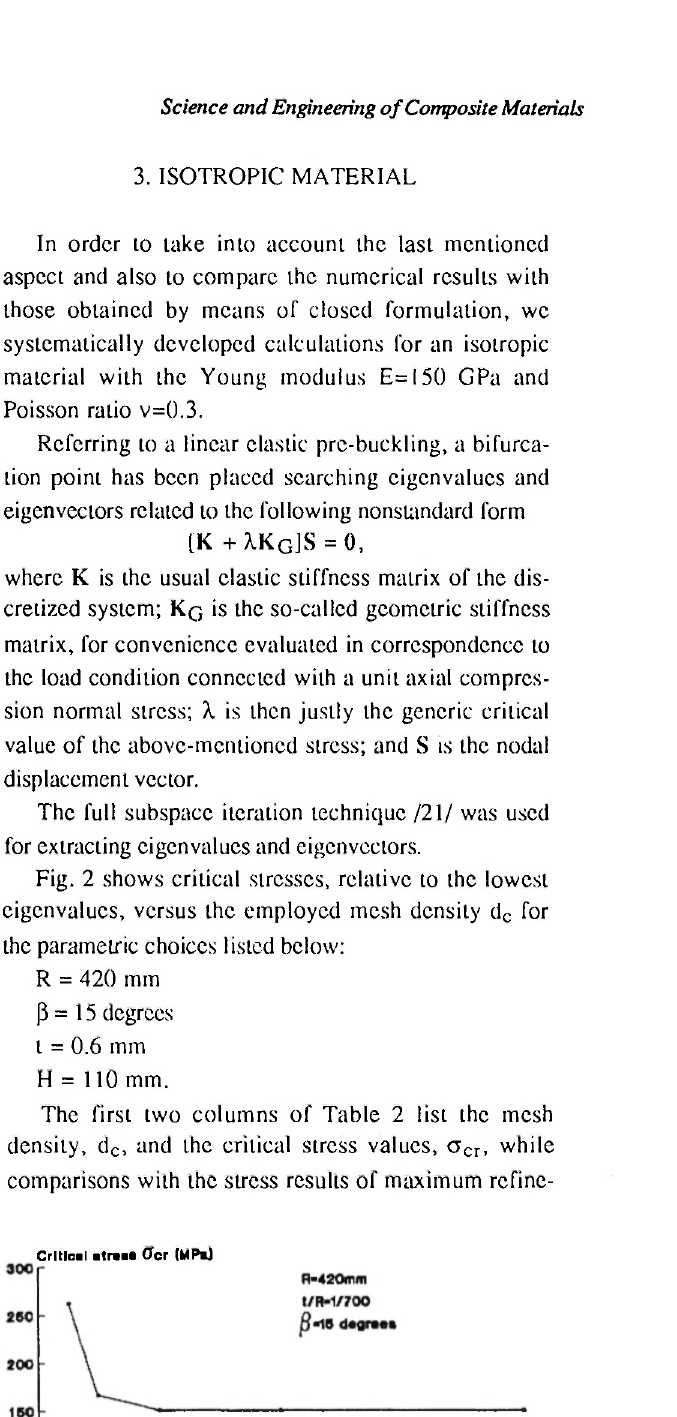
Influence of linear density d c on the solu- tion for